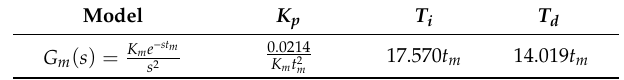
Figure 14. The obtained set of non-dominated solutions with normalized cost functions. Table 1. Controller’s gains calculation for the Åström’s robust loop shaping method.